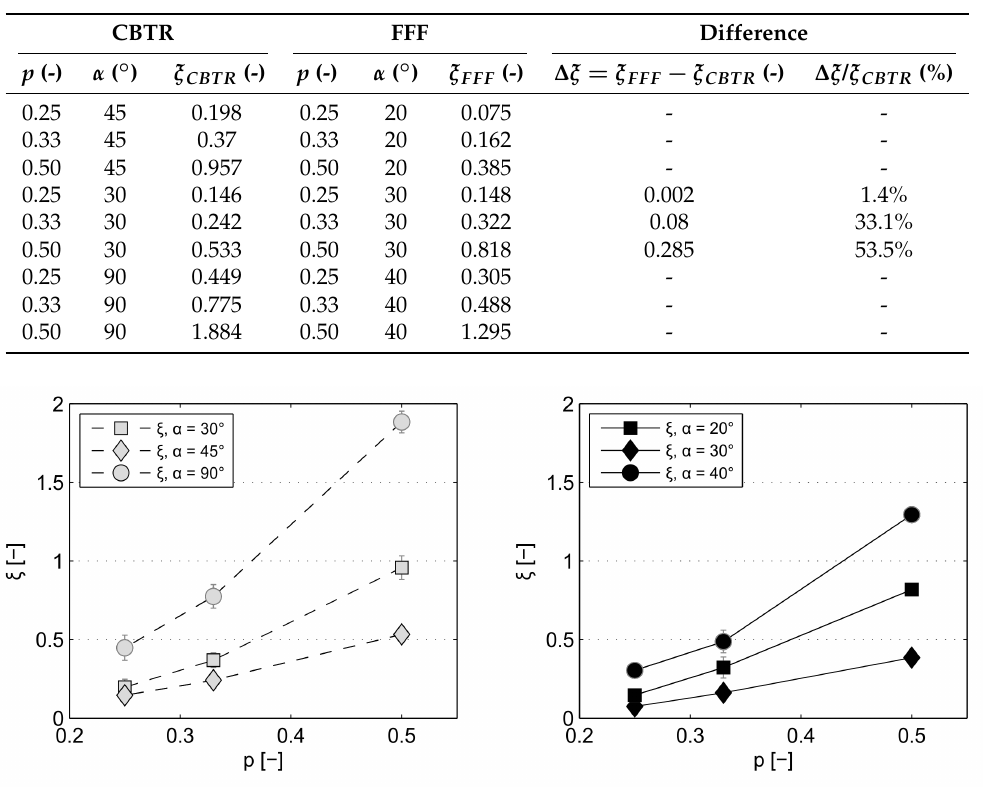
Figure 8. Head loss coefficient ξ versus blockage ratio p for the CBTR ( left ) and FFF option ( right ).